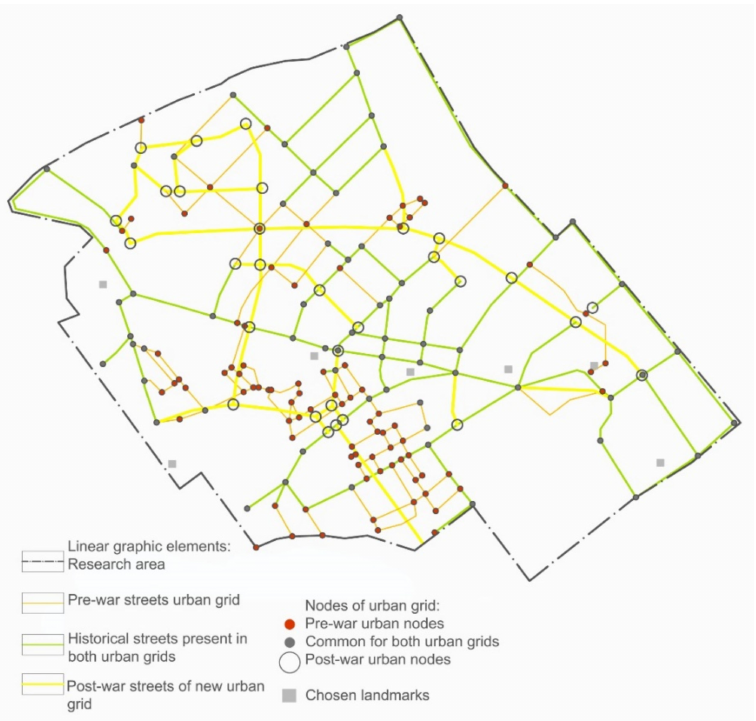
Figure 6. Summary diagram; prepared by M. Chodorowski.